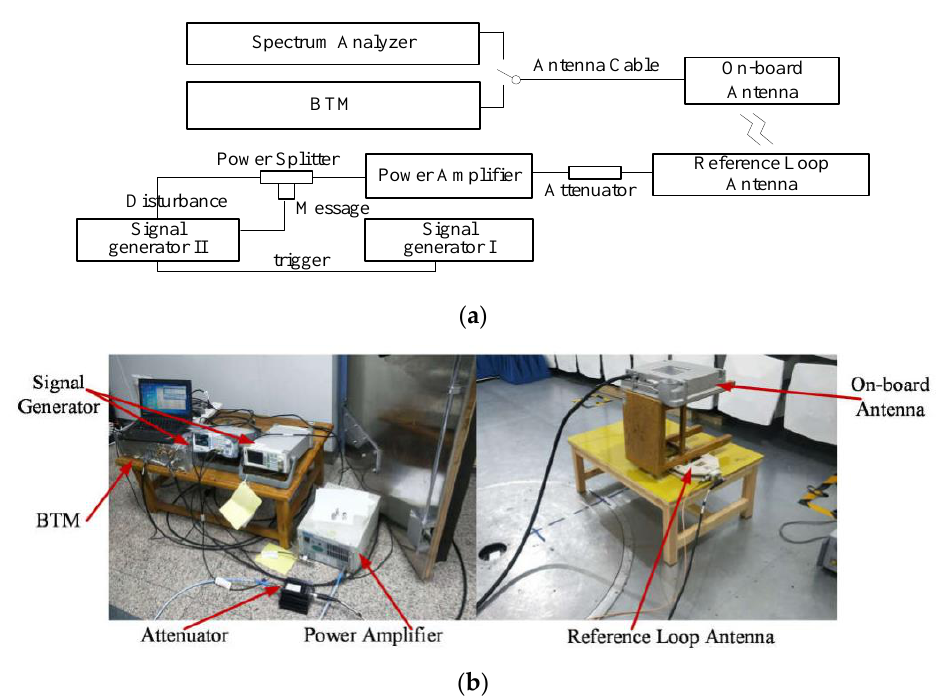
Figure 19. Measurement set-up: ( a ) Block diagram for device connection; ( b ) Experimental setup in semi-anechoic chamber.